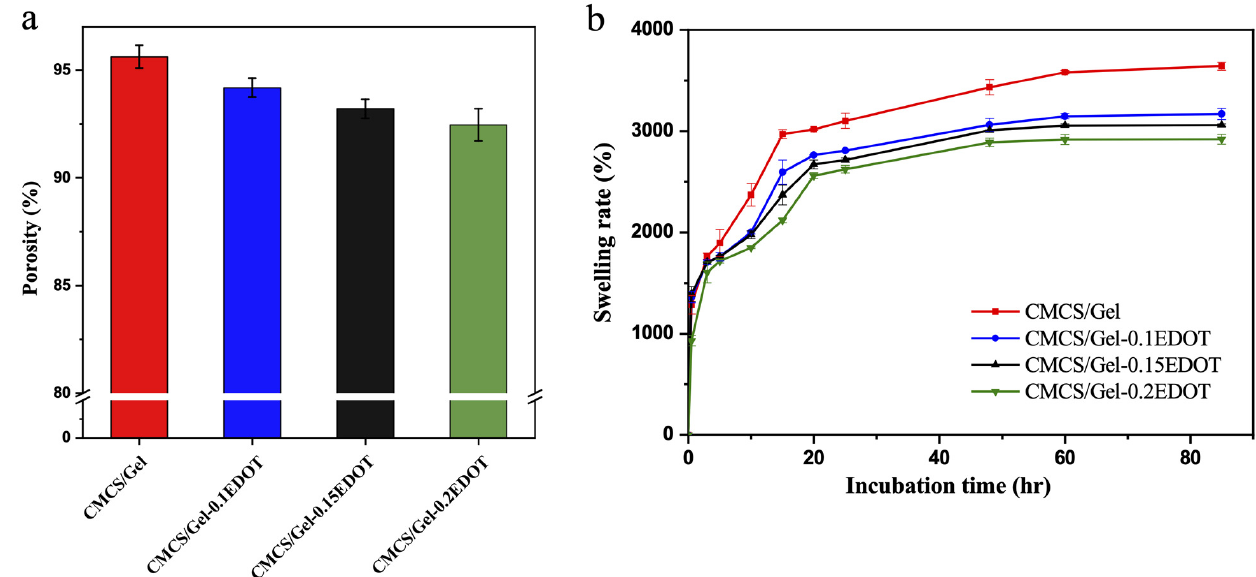
Figure 4. The porosity ( a ) and swelling rate ( b ) of CMCS/Gel and CMCS/Gel-PEDOT hydrogels.